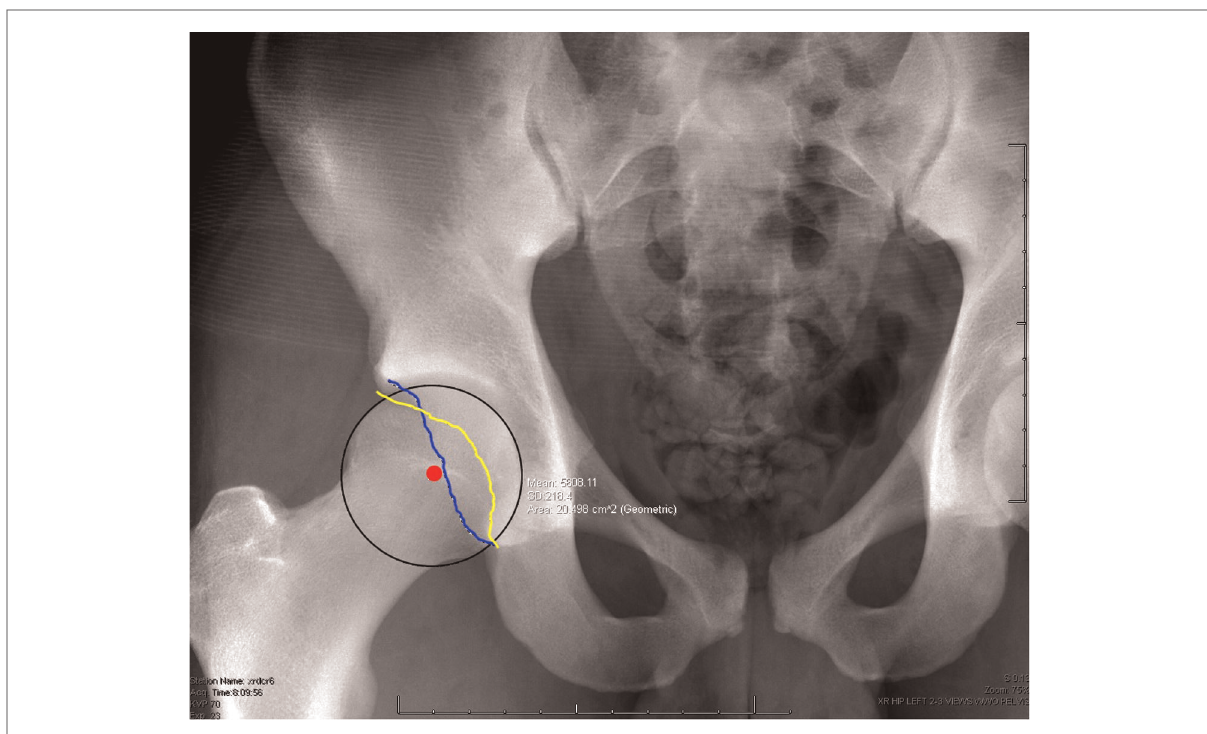
FIGURE 3 Anteroposterior radiograph of the hip demonstrating the cross oversign associated with acetabular retroversion. In the image the yellow line represents the anterior rim of the acetabulum, blue line reprents the posterior rim, and the red dot is the middle of the femoral